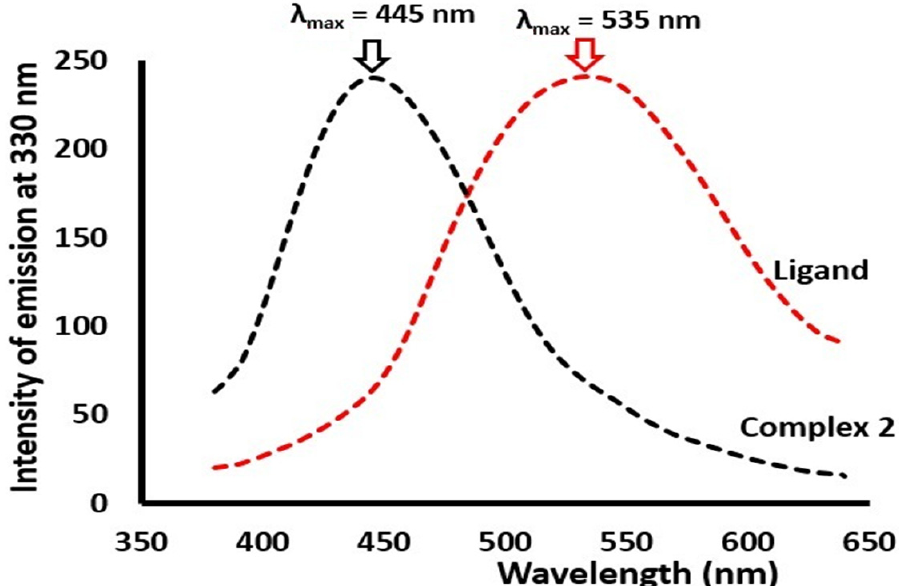
Figure 5. Emission spectra of 1 × 10 − 5 M of ligand and complex 2 dissolved in DMSO at RT.